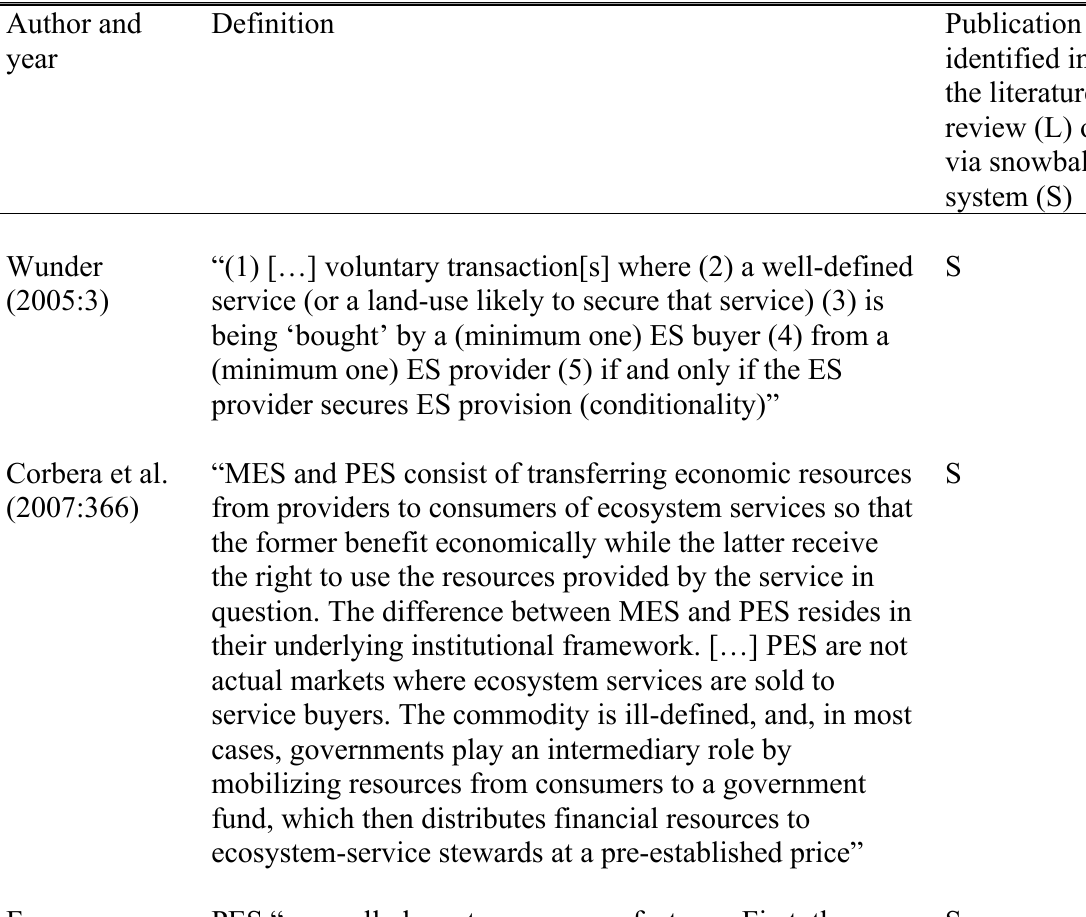
Table A1. Identified PES